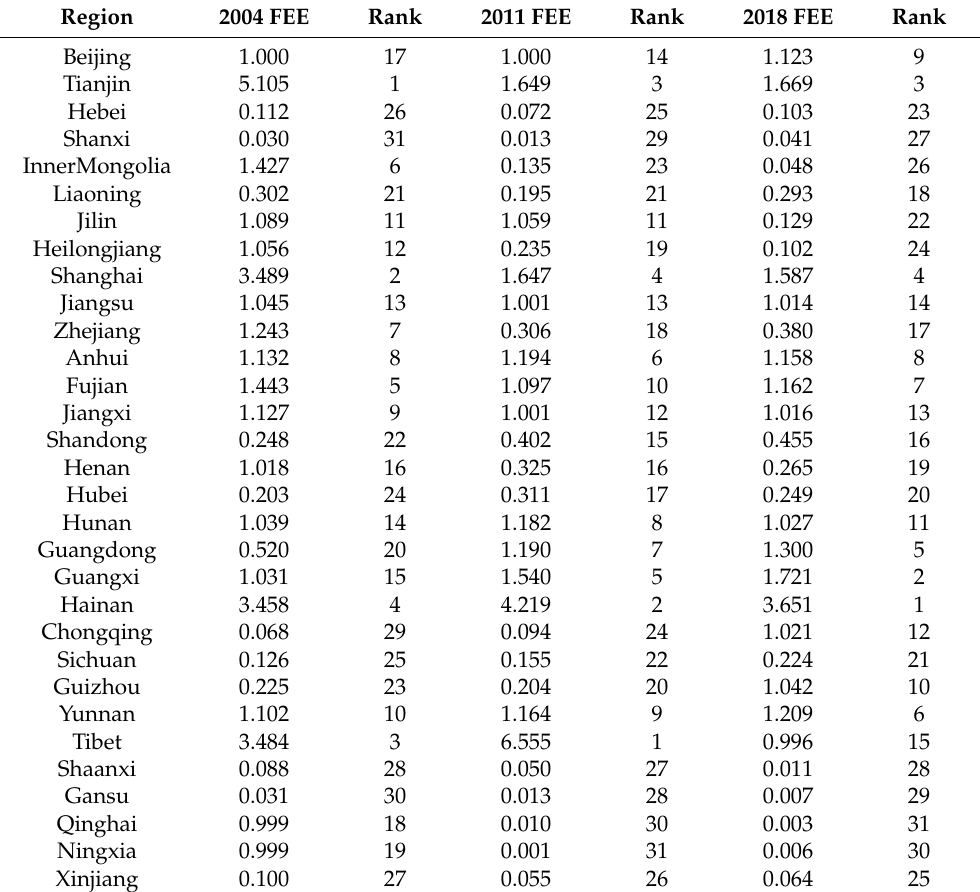
Table 3. Forestry ecological efficiency values of 31 provinces and cities in China in 2004, 2011 and 2018.